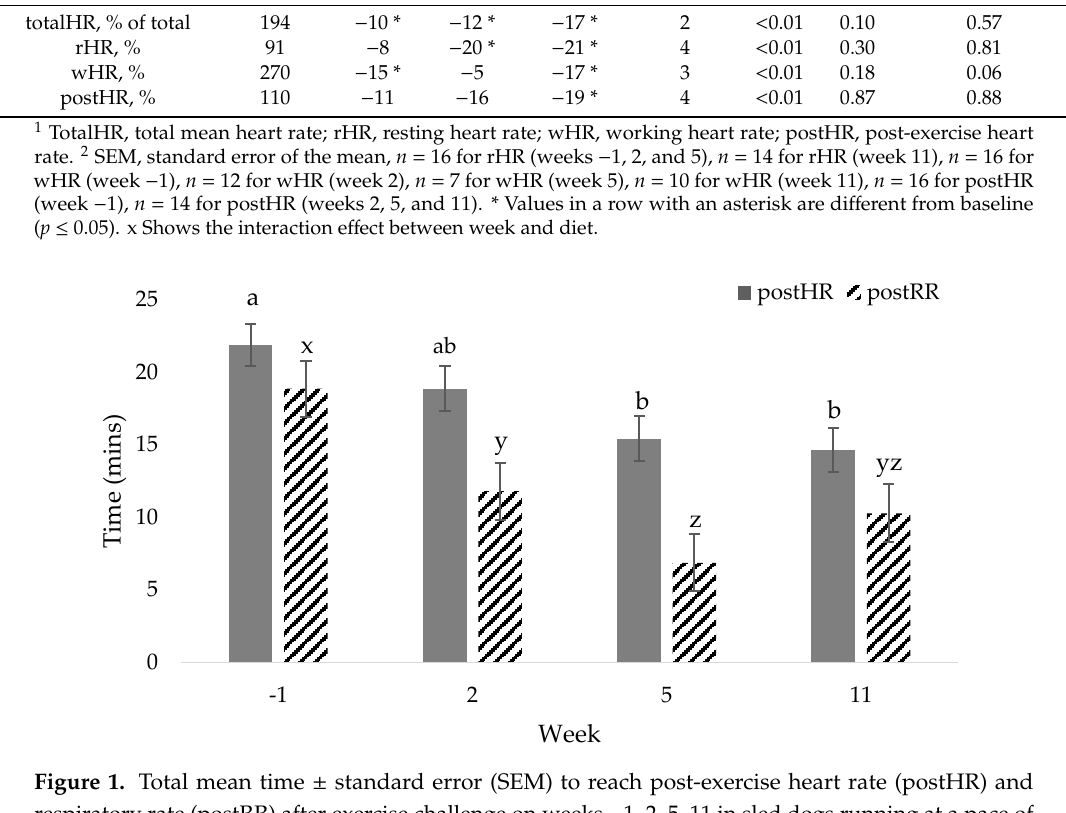
Figure 1. Total mean time ± standard error (SEM) to reach post-exercise heart rate (postHR) and respiratory rate (postRR) after exercise challenge on weeks −1, 2, 5, 11 in sled dogs running at a pace of 15 km/h for 4 km. a,b,c HR or RR values with different superscripts are different among weeks ( p < 0.05).